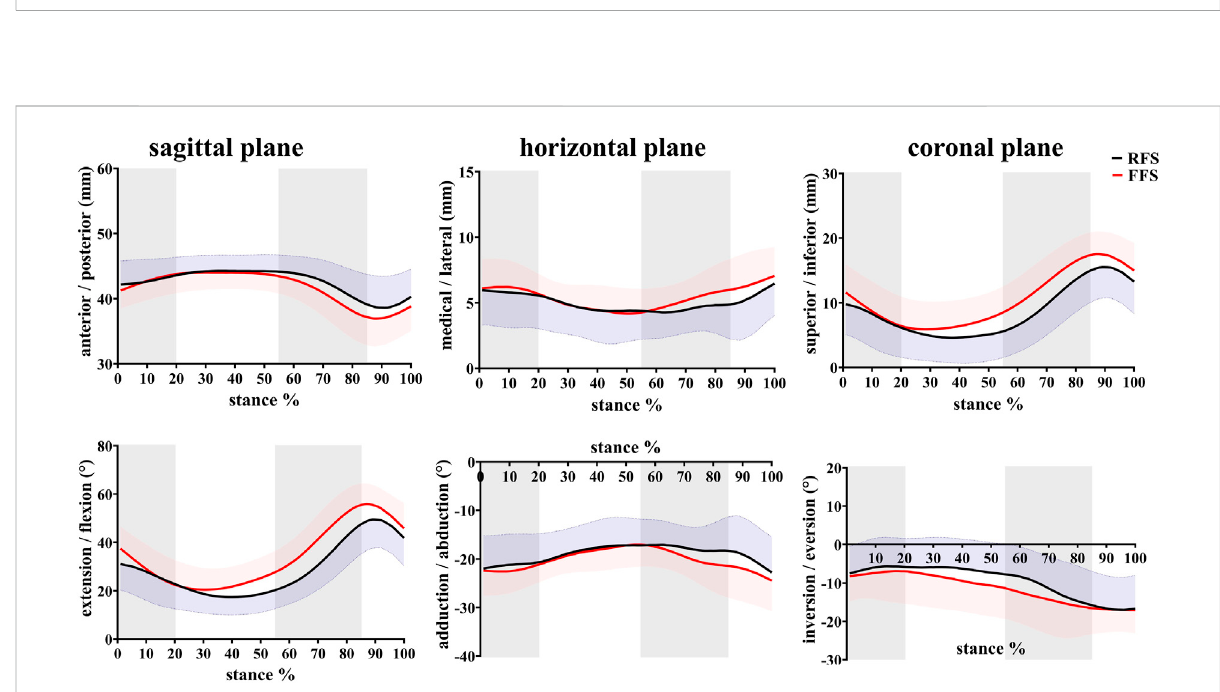
FIGURE 6 Effects of different foot strike patterns on the in vivo kinematics data of the fi rst MTPJ during the stance phase of running. Note: RFS, rearfoot strike pattern and FFS, forefoot strike pattern.